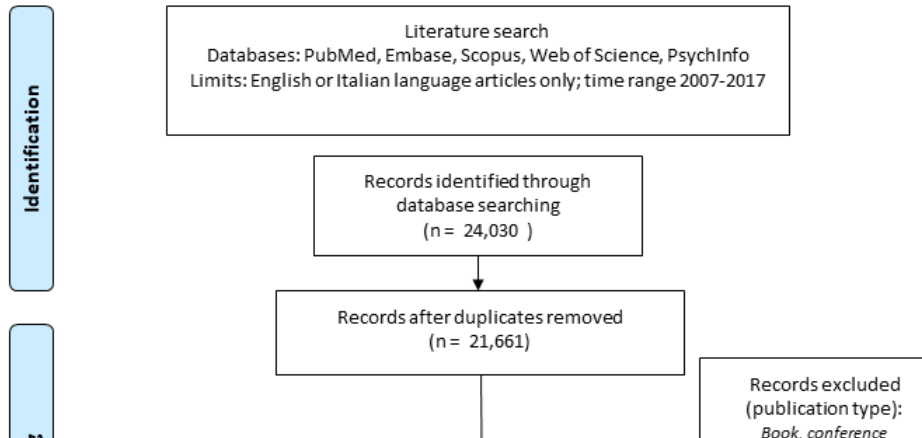
Figure 1. Prisma flow diagram.